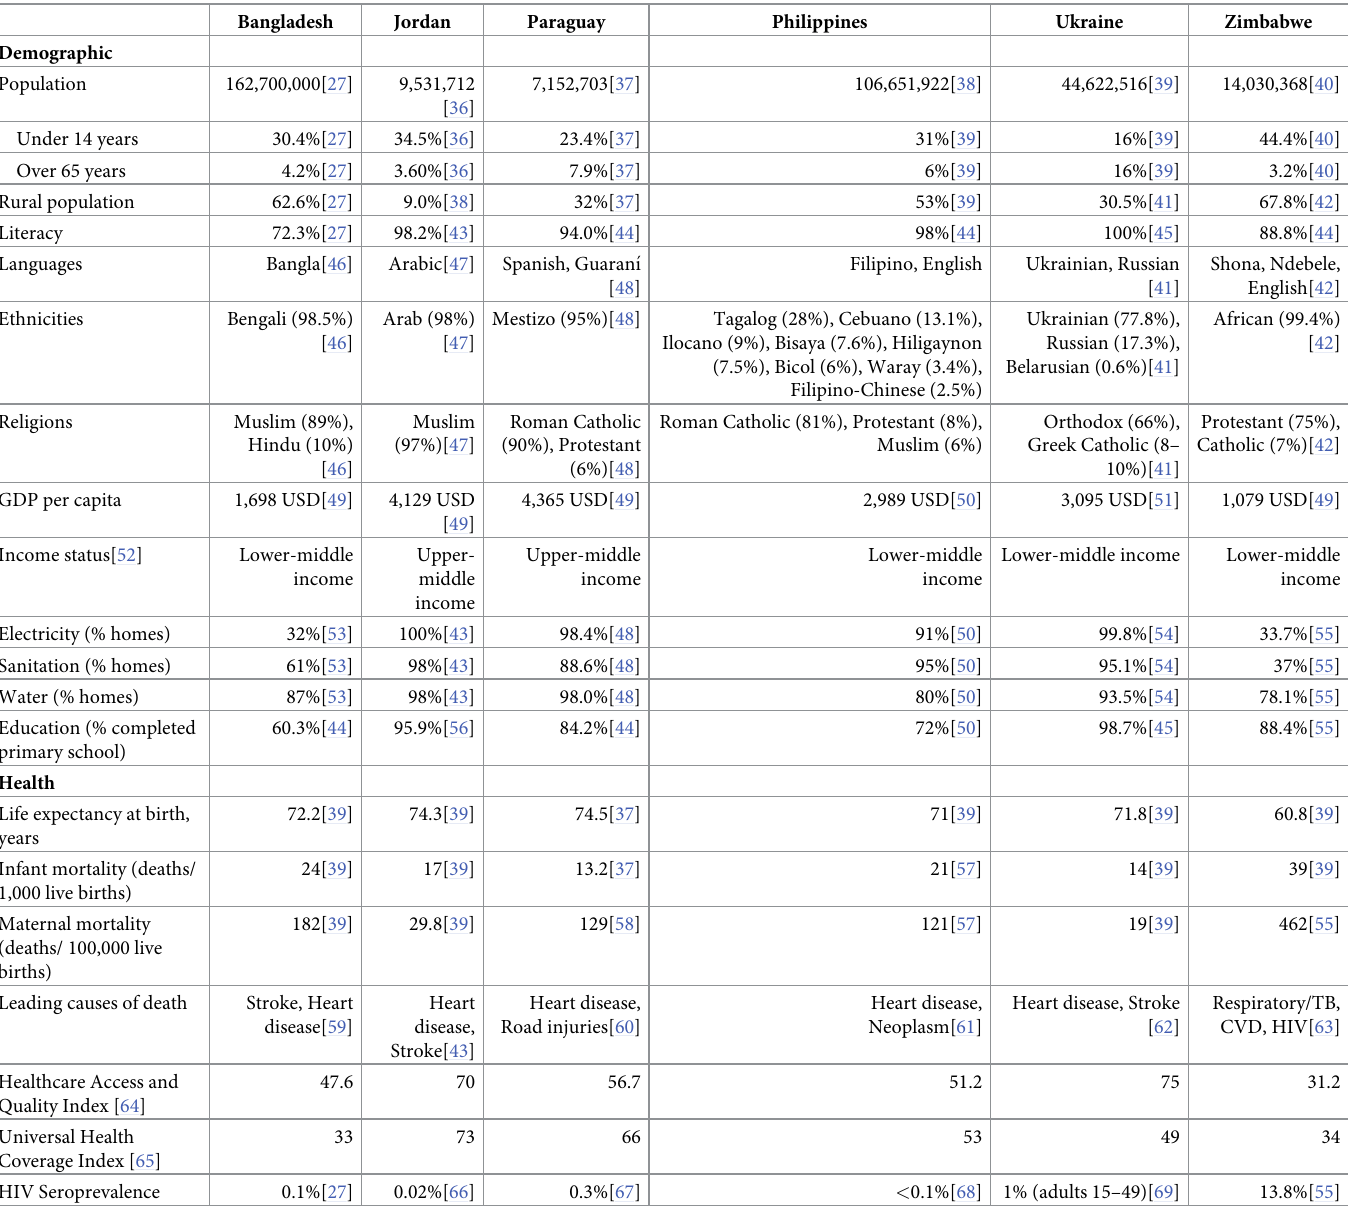
Table 1. National demographic and health